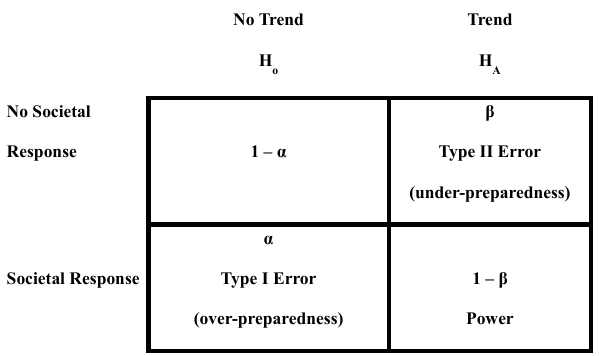
Fig. 1. Decision matrix for the general trend detection decision Figure 1 – Decision Matrix for the General Trend Detection Decision Problem, with problem, with null hypothesis H o and alternate hypothesis H A Null Hypothesis H o and Alternate Hypothesis H A shown